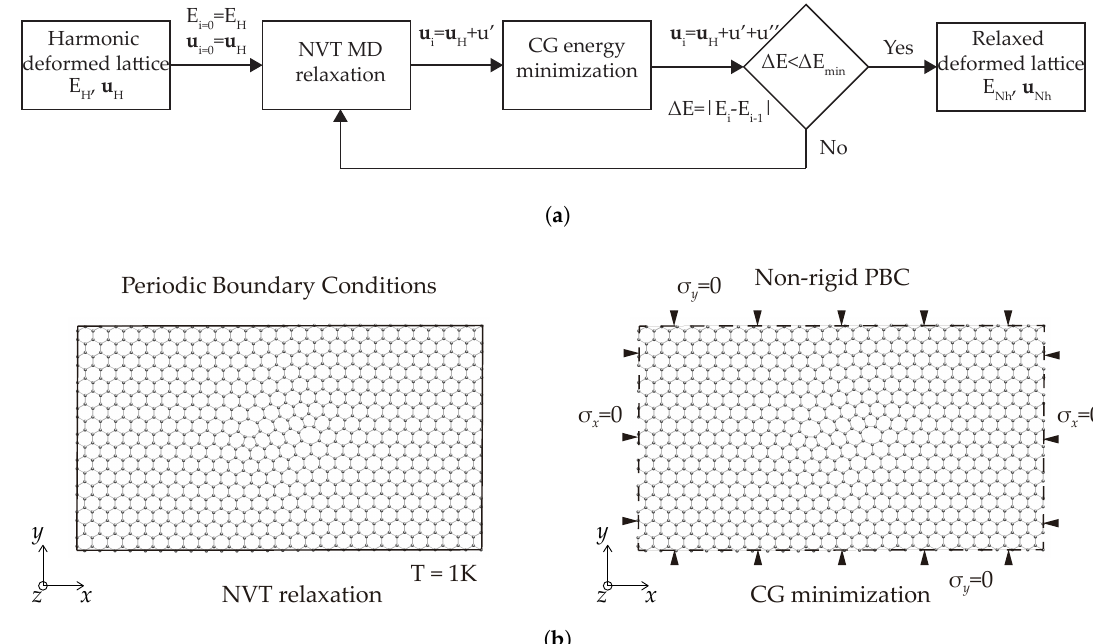
Figure 5. ( a ) Flowchart of the nonlinear relaxation scheme and ( b ) outline of the boundary conditions for the nonlinear relaxation